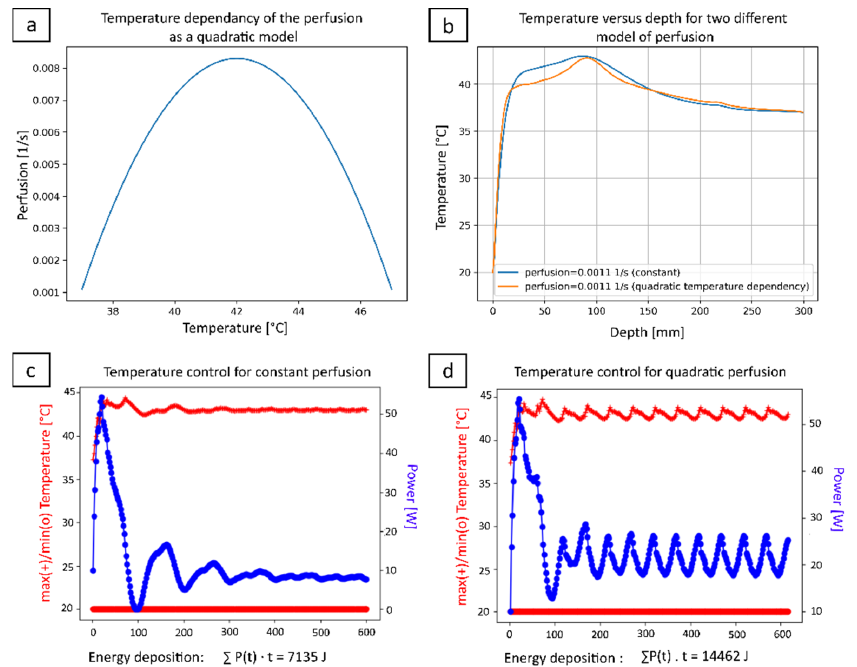
Figure 4. Prediction of the performance of the device in perfused tissue, for a constant perfusion model p = 0.0011 s − 1 and, respectively, for a quadratic temperature-dependant perfusion shown in ( a ). ( b ) Simulation of the temperature profile along the acoustic axis during hyperthermia for the two perfusion models; ( c – d ) Plot of the estimated action of the feedback controller for both cases, with cumulated energy emission reaching 7.1 kJ and 14.5 kJ, respectively.